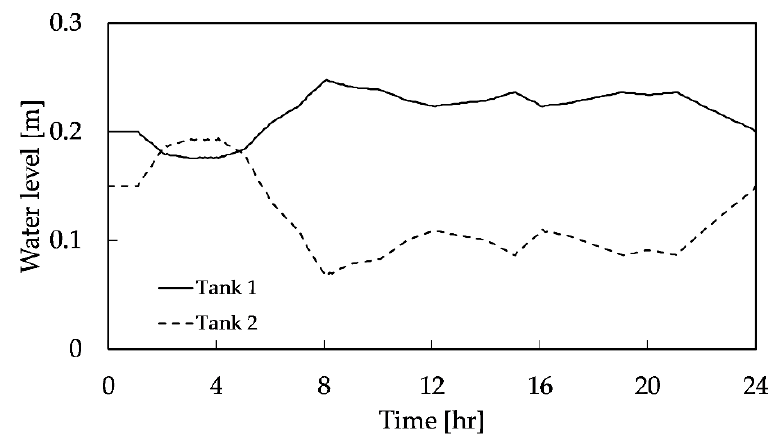
Figure 15. The water level in T-1 and T-2 based on the variable demand pattern.